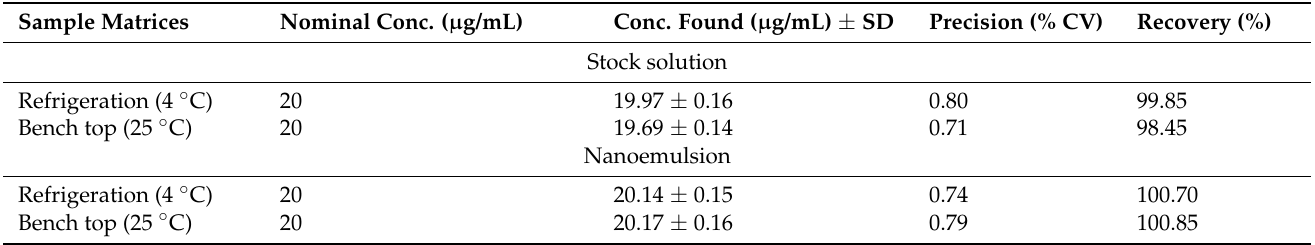
Table 7. Stability data of CCM in stock solution and nanoemulsion formulation at MCQ level at two different temperatures (mean ± SD; n = 3).